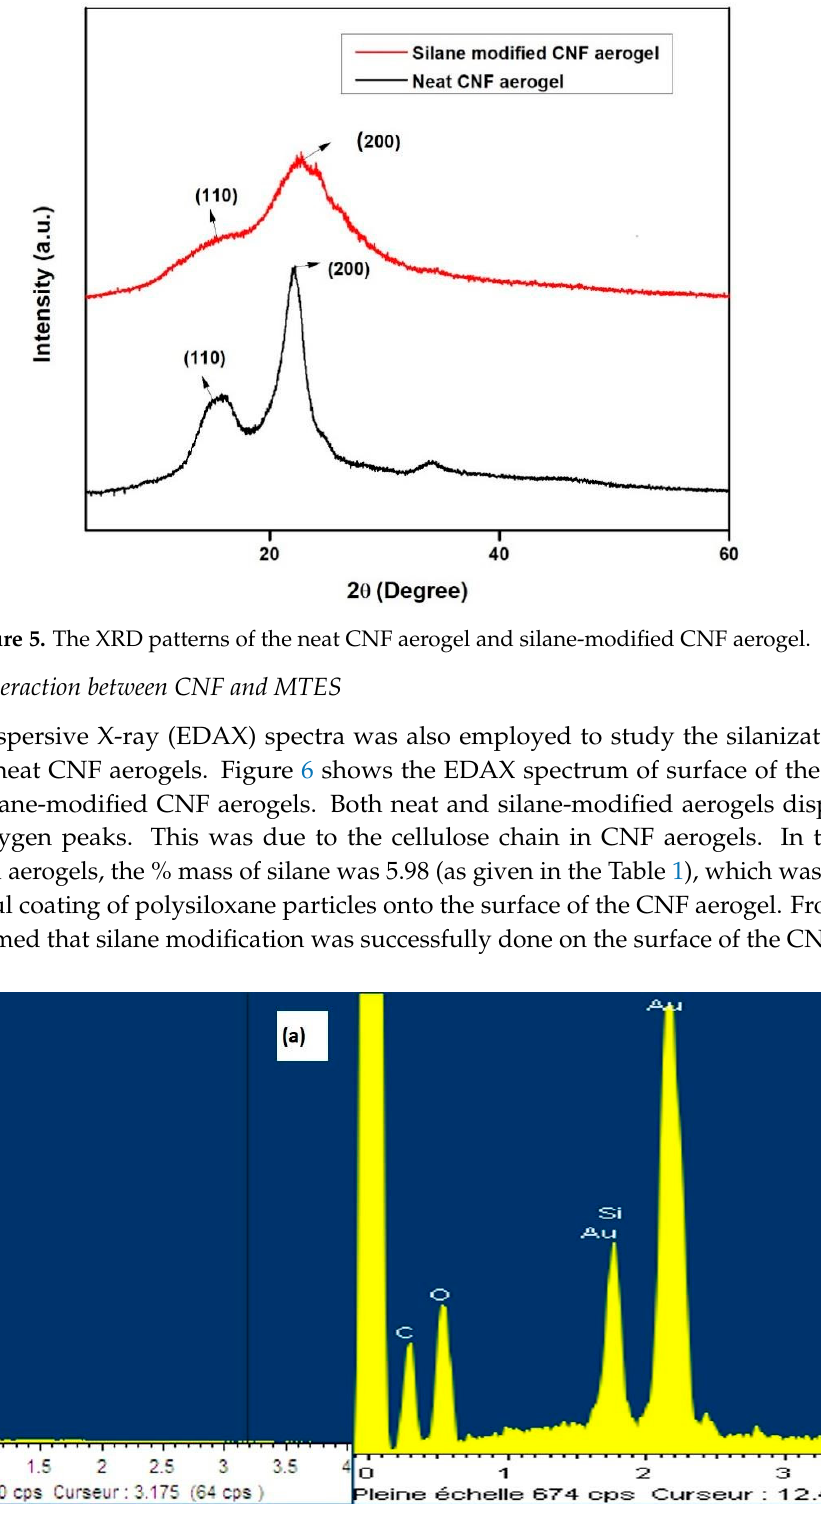
Figure 6. Energy-dispersive X-ray (EDAX) spectra of the neat CNF aerogel and the silane-modified CNF aerogels. The gold picks are due to the gold coating needed for SEM images. Table 1. Elemental composition of the silane-modified CNF aerogels.